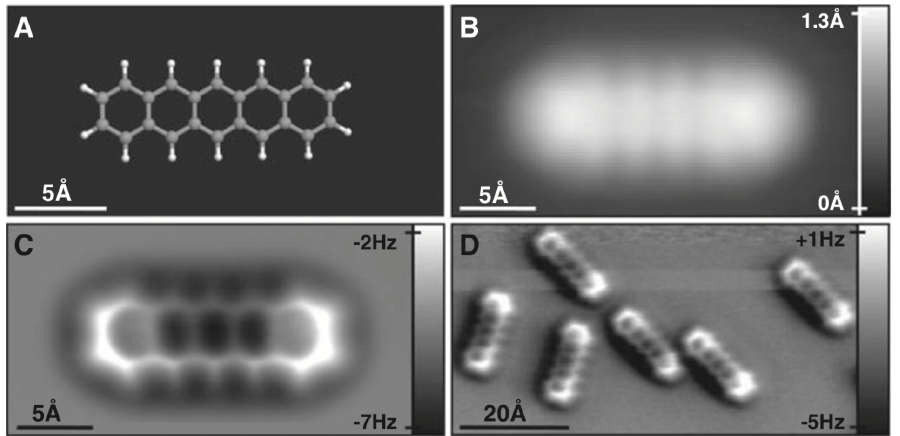
Figure 12. STM and AFM imaging of pentacene on Cu(111). ( A ) Ball-and-stick model of the pentacene molecule. ( B ) Constant-current STM and ( C , D ) constant-height AFM images of pentacene acquired with a CO-modified tip. Imaging parameters are as follows: ( B ) set point I = 110pA, V = 170mV; ( C ) tip height z = − 0.1Å (with respect to the STM set point above Cu(111)), oscillation amplitude A = 0.2Å; and ( D ) z = 0.0Å, A = 0.8Å. The asymmetry in the molecular imaging in ( D ) (showing a “shadow” only on the left side of the molecules) is probably caused by asymmetric adsorption geometry of the CO molecule at the tip apex. Adapted with permission by American Association for the Advancement of Science from Figure 1 in